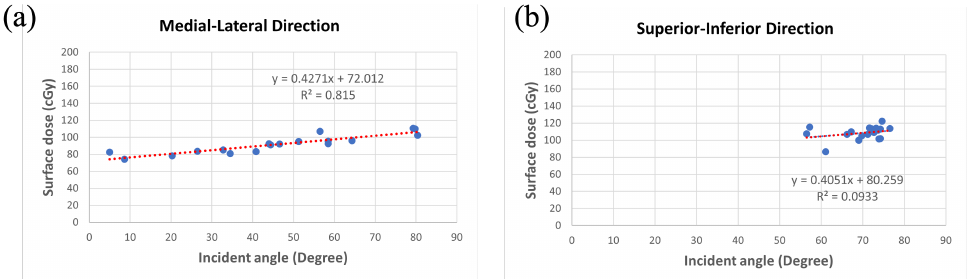
Figure 6. The relationship between surface dose and incident angle. Both the trendlines (red dashed lines) are under linear regression as above. ( a ) The medial-lateral direction and ( b ) the superior- inferior direction.